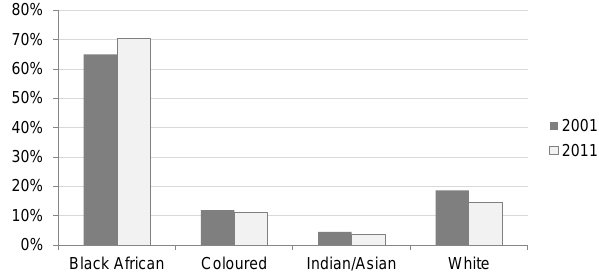
Figure 4: Labour force by population group